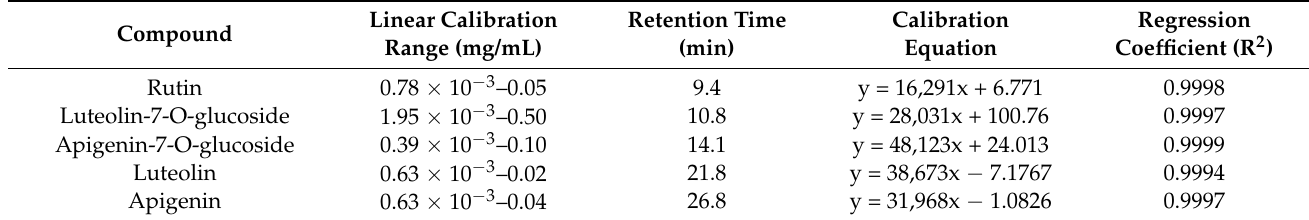
Table 5. Standard curve of other phenolic compounds.